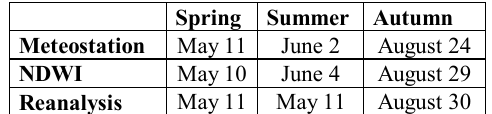
Figure 4. Trend graphs of the averaged surface air temperature at Syktyvkar meteorological station according to Reanalysis-1